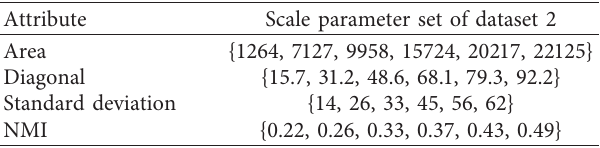
Table 2: Extracted scale parameter set of dataset 2. Attribute